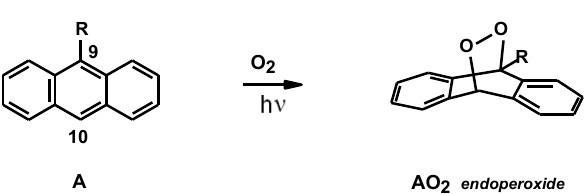
Figure 1. Addition of singlet oxygen to 9-alkylanthracenes (hetero Diels-Alder reaction).